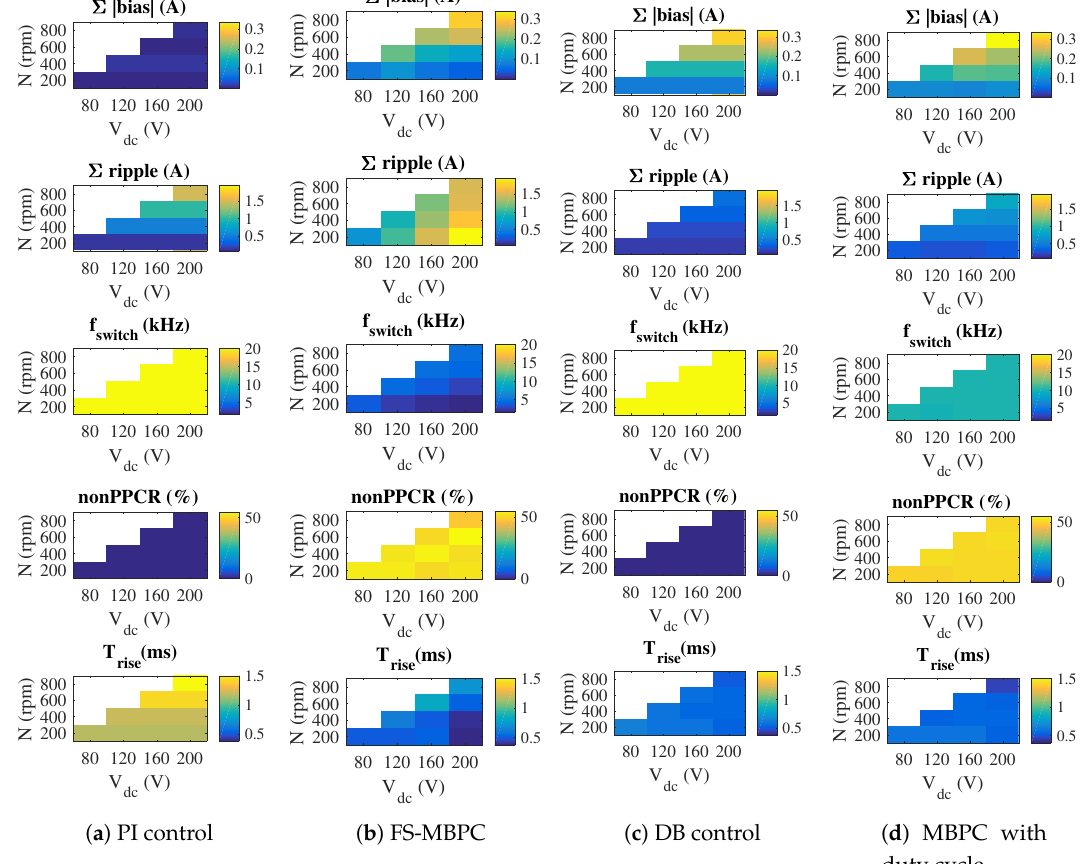
Figure 18. Effect of DC-bus voltage V dc and mechanical speed N on the KPIs for a faulty